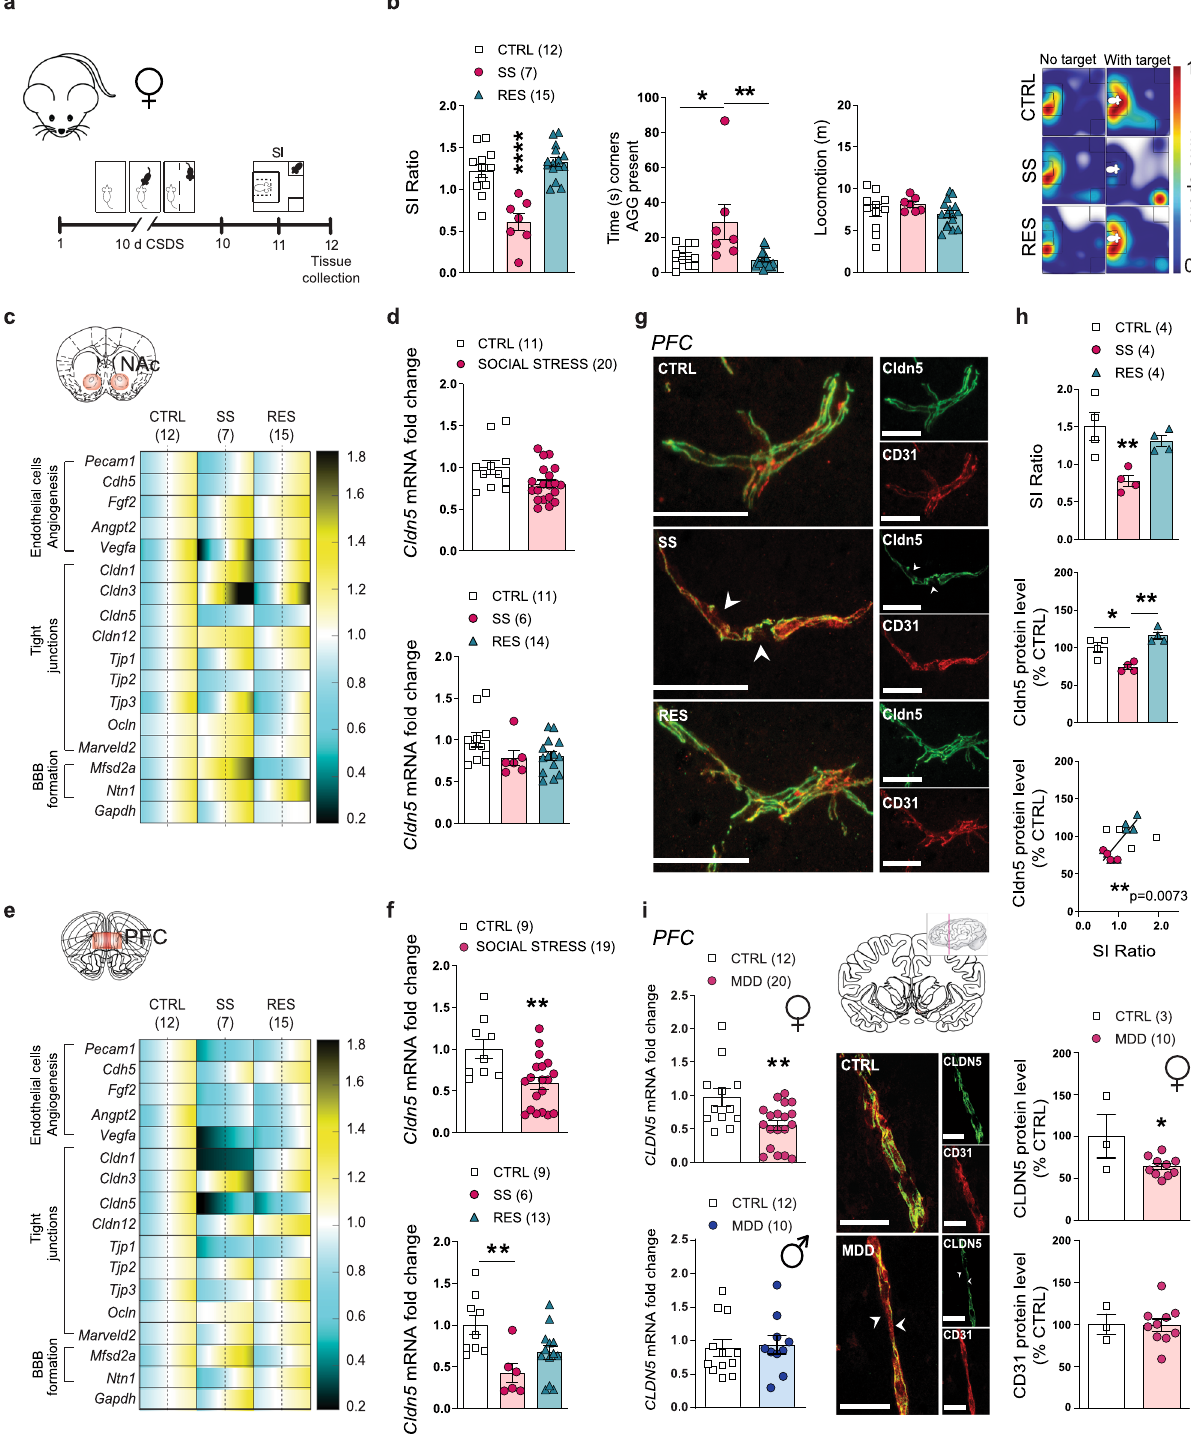
Region-speci fi c vascular changes promoted by subchronic variable stress in line with anxiety- and depression-like behaviours Female rodents are more vulnerable to unpredictable stress with 6 consecutive days of variable stressors being suf fi cient to induce anxiety- and depression-like behaviours in females but not males 15 , allowing for an exploration of the mechanisms under- lying sex-speci fi c stress responses. Female mice were exposed to a series of three different stressors namely foot shocks, tail